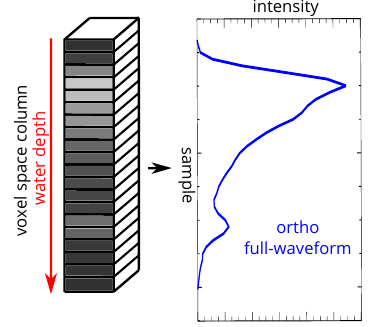
Figure 7. Principle of ortho full-waveform generation from voxel-based data representation. Bright gray value = high intensities; dark gray value = low intensities.